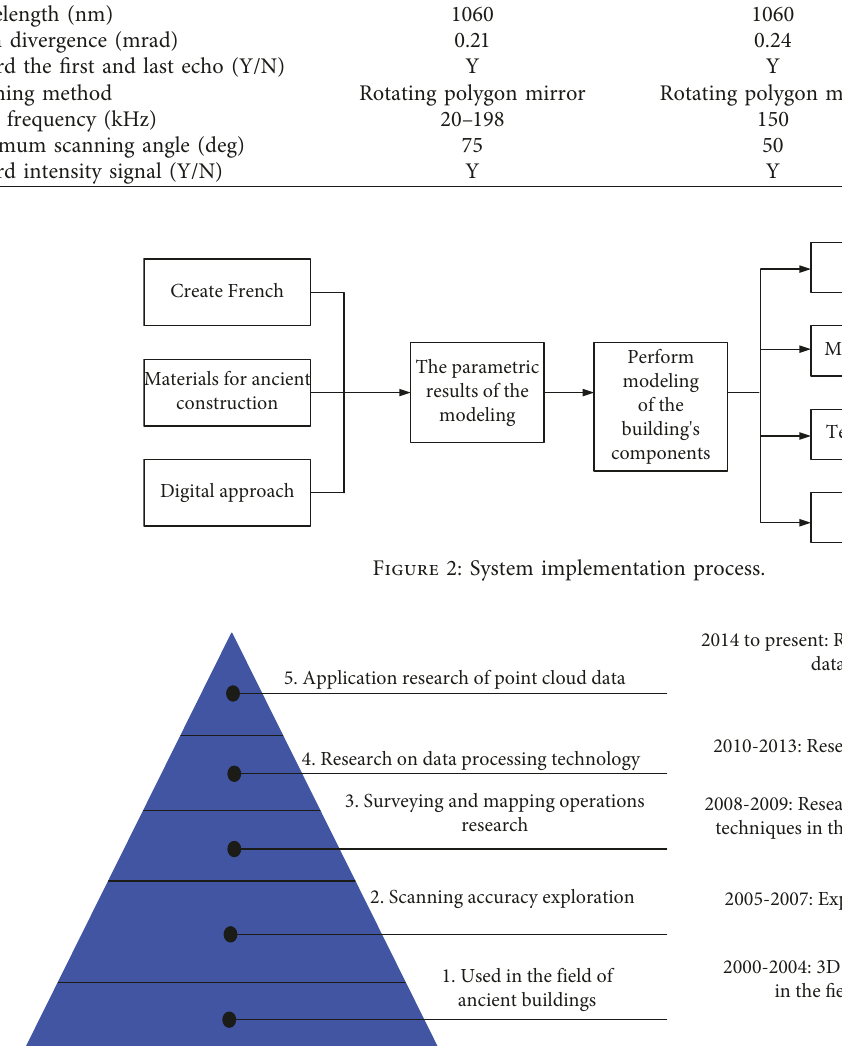
Figure 3: Development history of 3D laser scanning technology.